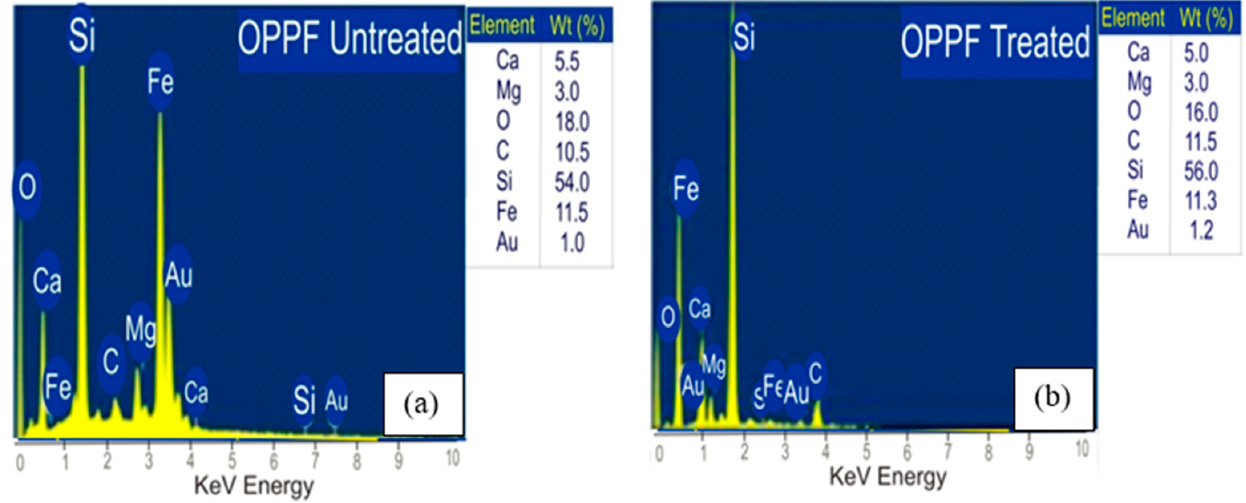
Figure 2. Elemental composition of ( a ) untreated OPPF fiber and ( b ) treated OPPF Fiber.